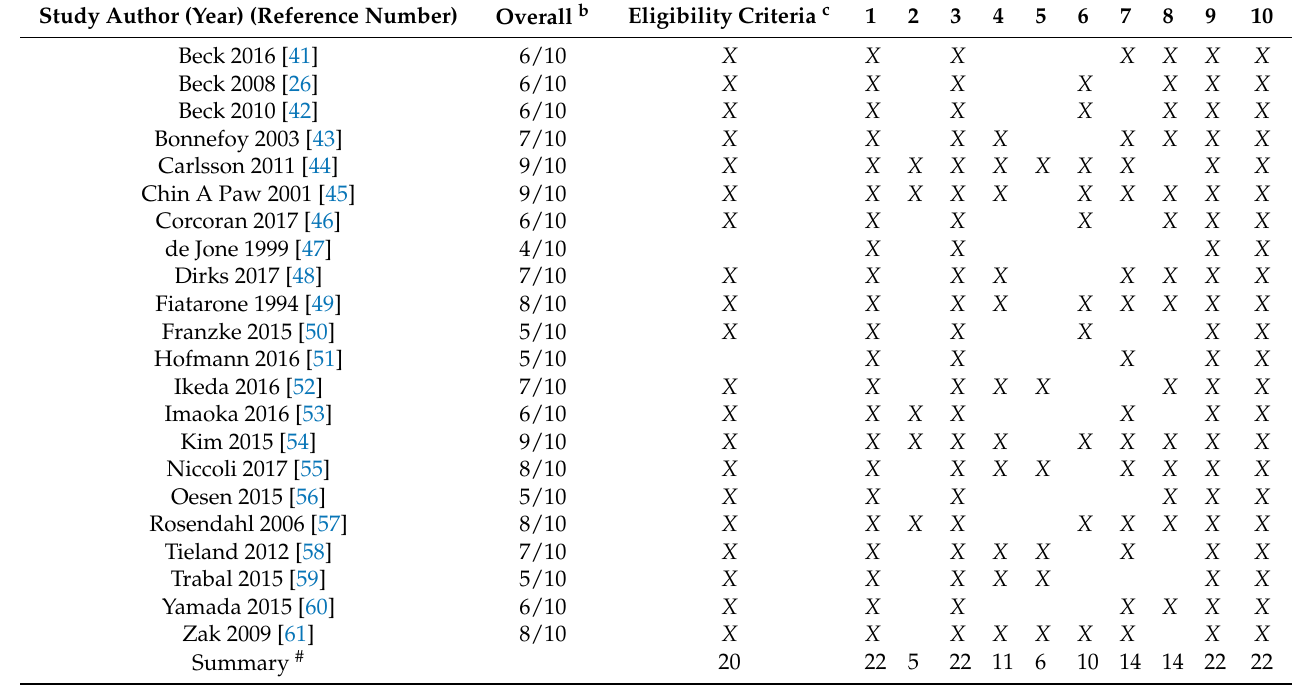
Table 2. Summary of methodological quality based on the PEDro classification scale a